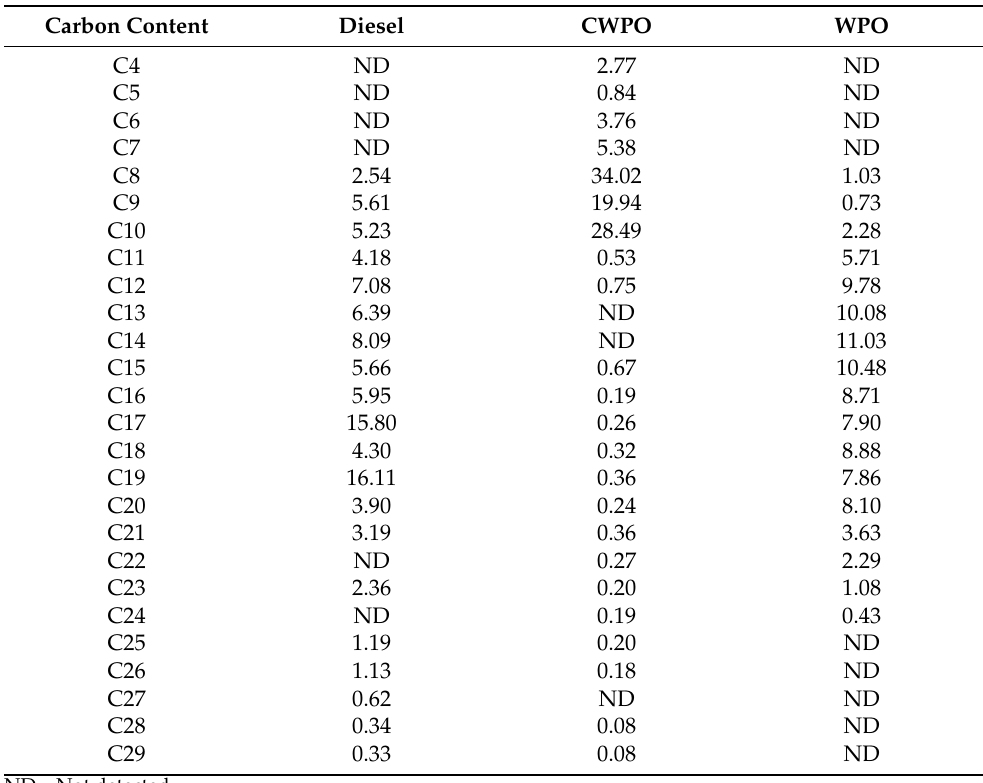
Table 3. Components of diesel and WPO by GC–MS analysis.